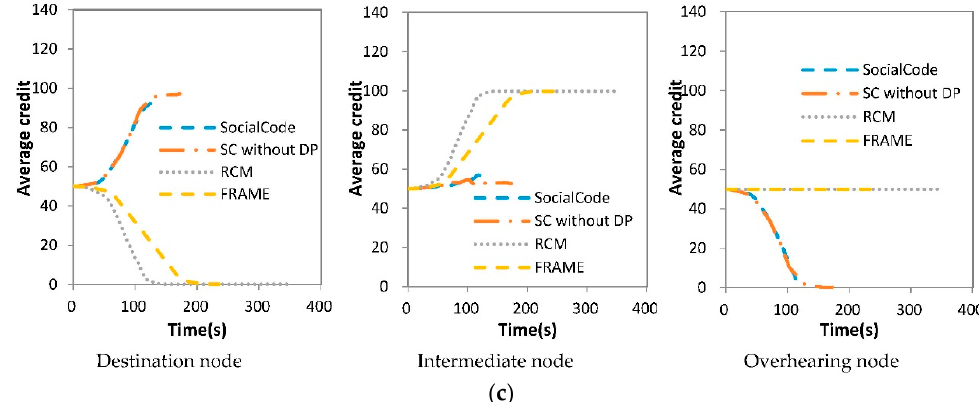
Figure 11. Average credit vs. file size ( a ) 10 MB; ( b ) 6 MB; ( c ) 2 MB.